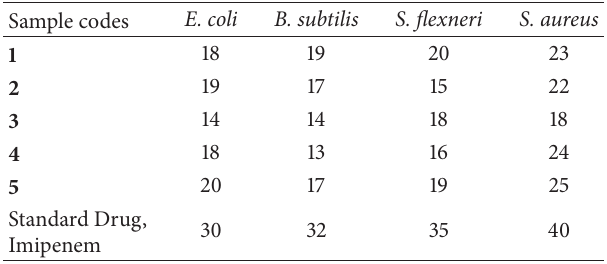
Table 2: Antibacterial activity of the complexes (in vitro) against four different bacterial pathogens (diameter of inhibition zone in mm).